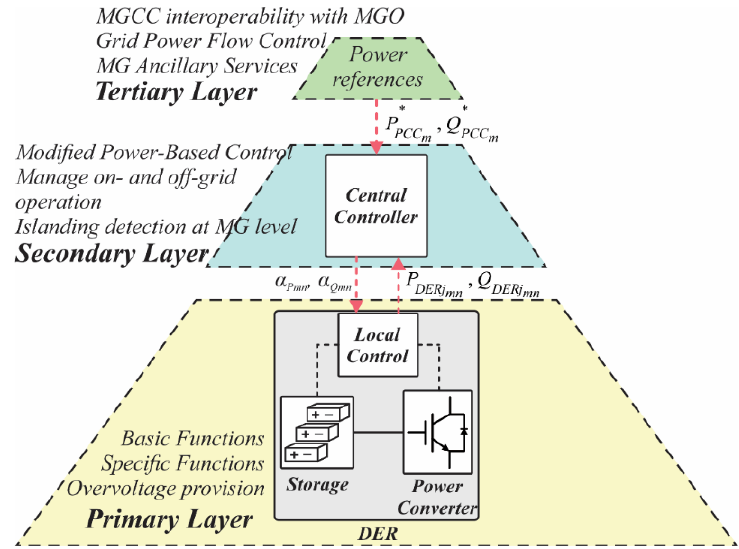
Figure 3. Microgrid hierarchical control organization.